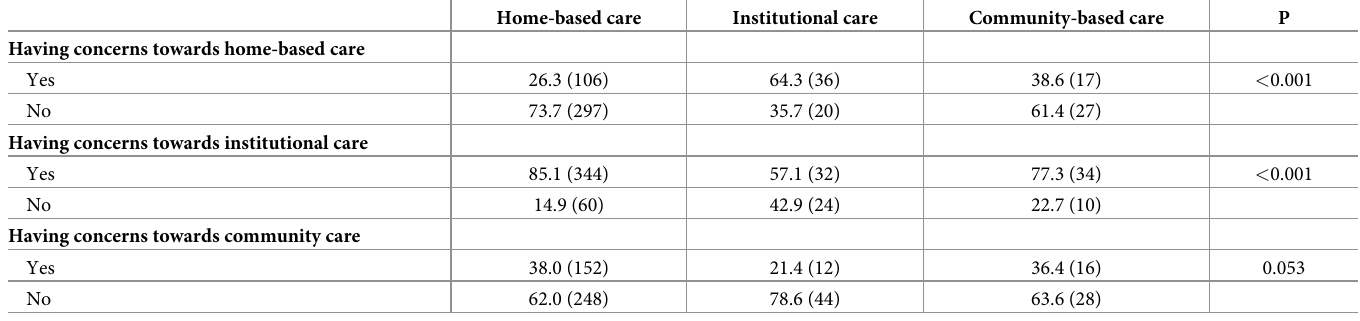
Table 3. Concerns toward three types of eldercare among the